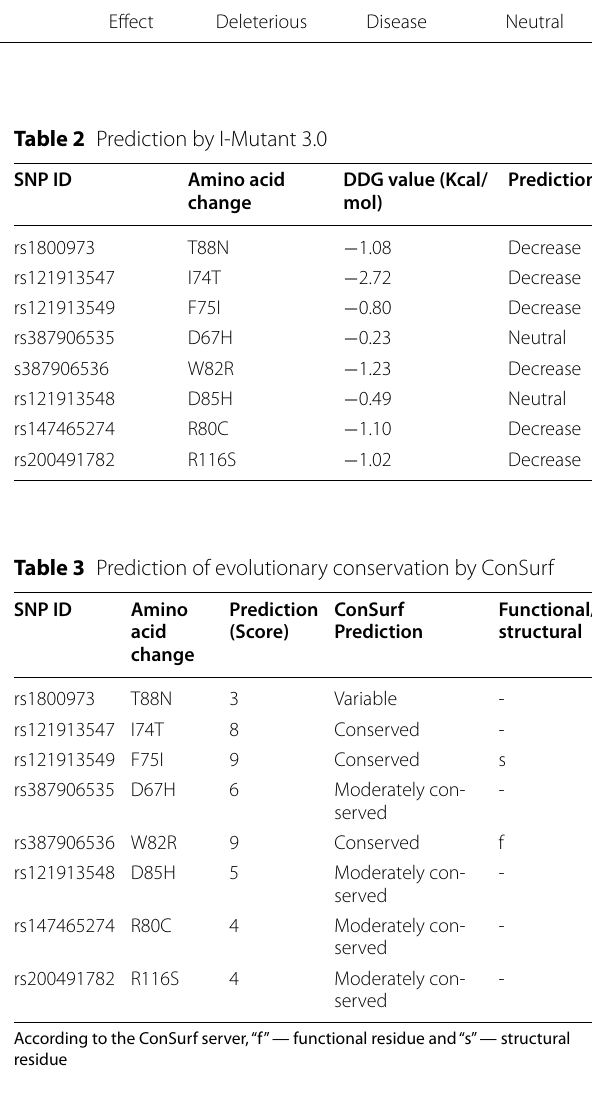
PD Probably damaging